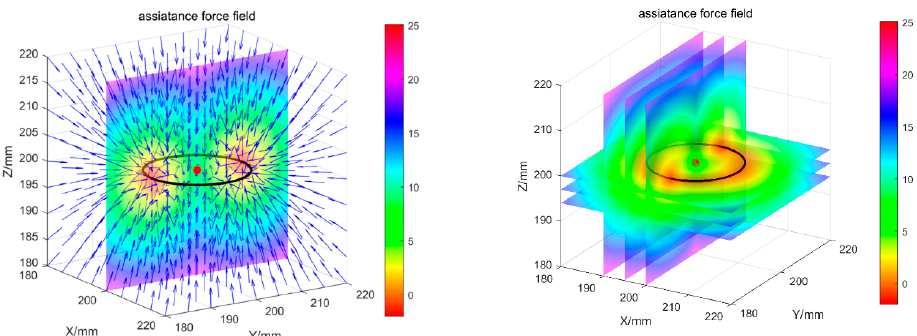
Figure 6. The schematic diagram of the assistance force field for a circle trajectory without a virtual channel.